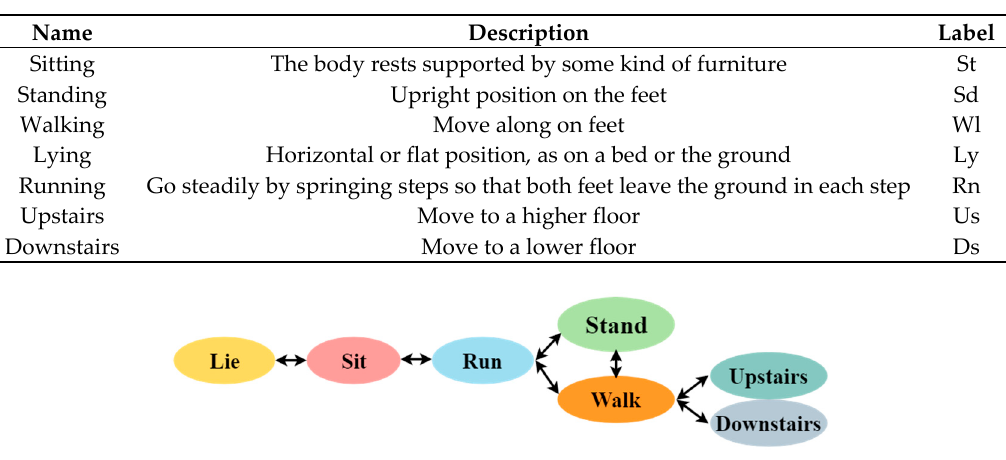
Table 1. User states overview.